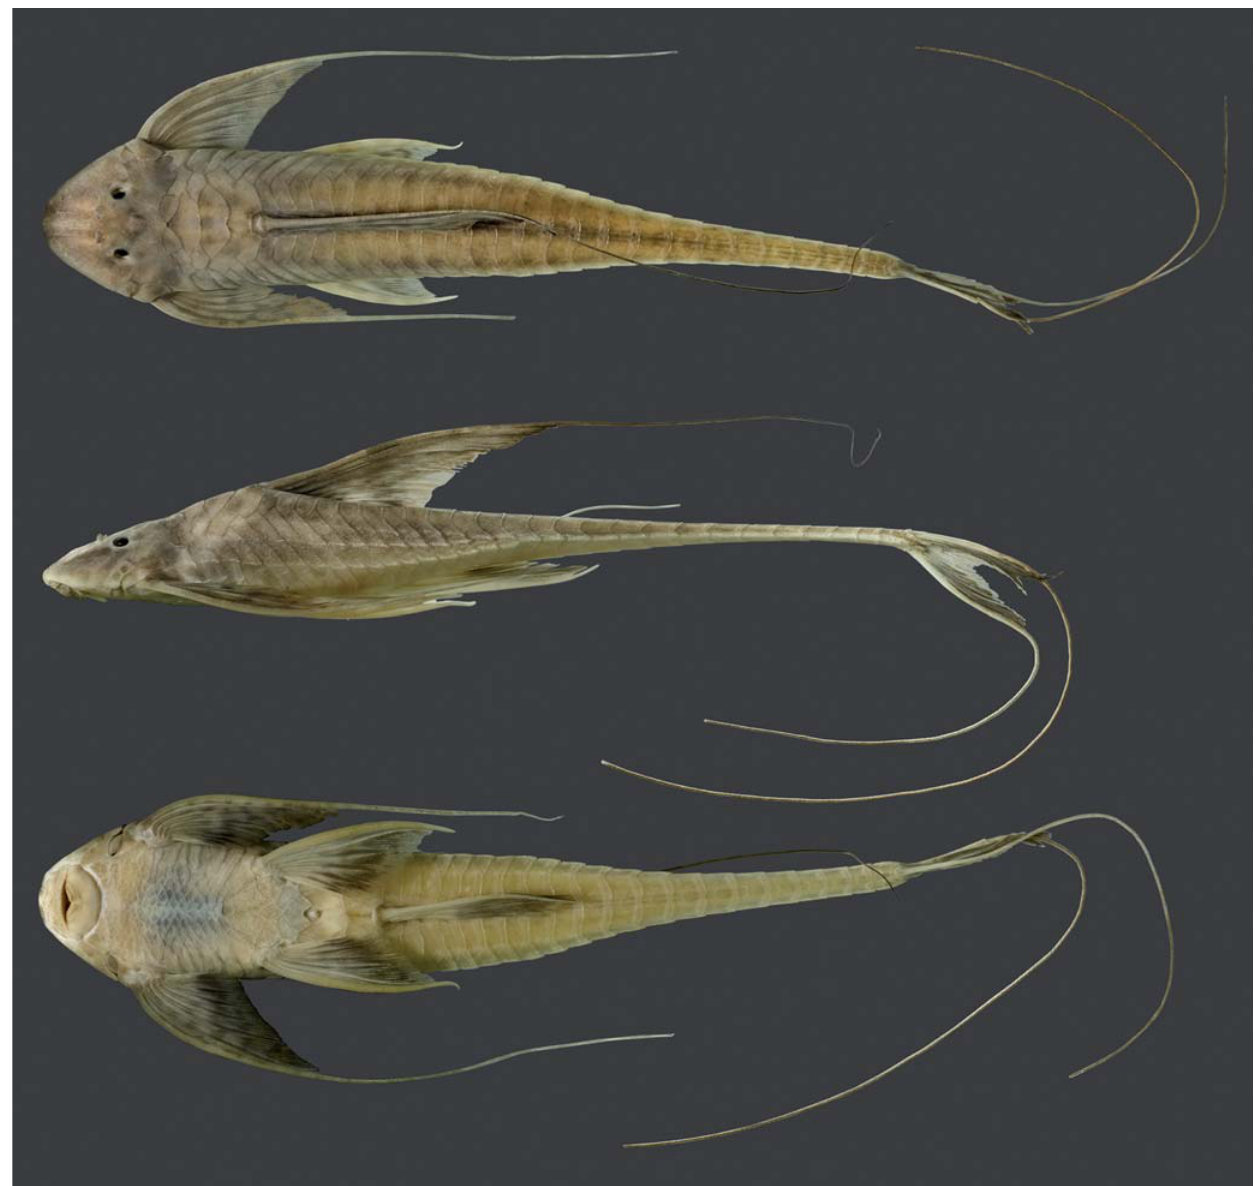
Fig. 10. Lamontichthys filamentosus , MZUSP 85803, 158.6 mm SL. Dorsal, lateral and ventral